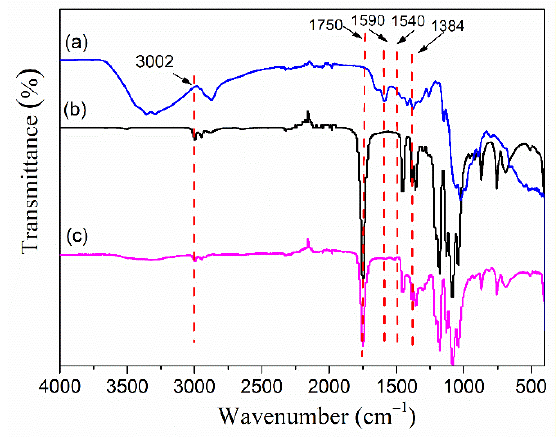
Figure 1. FTIR spectra of ( a ) chitosan; ( b ) control PLA nonwoven fabrics; ( c ) DBD-CS-Ag NPs treated fabric.